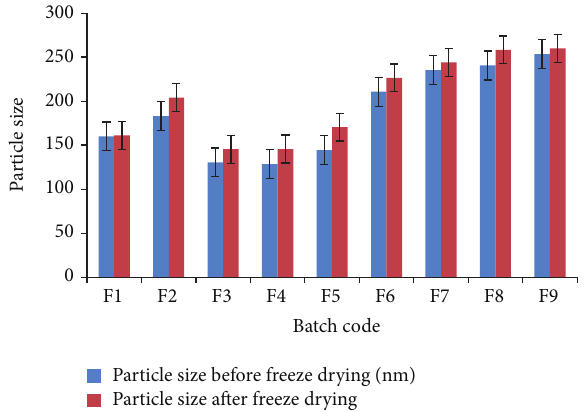
Figure 3: Effect of polymer concentration on particle